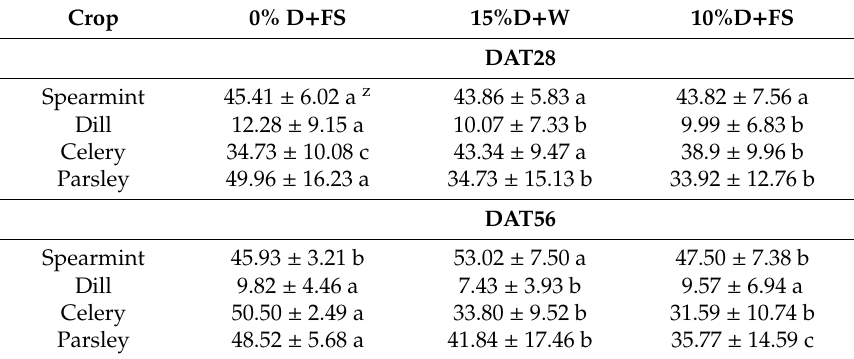
Table 4. Mean (and standard deviation) chlorophyll content values (CCI) measured in the secondary crops. Crop 0% D +